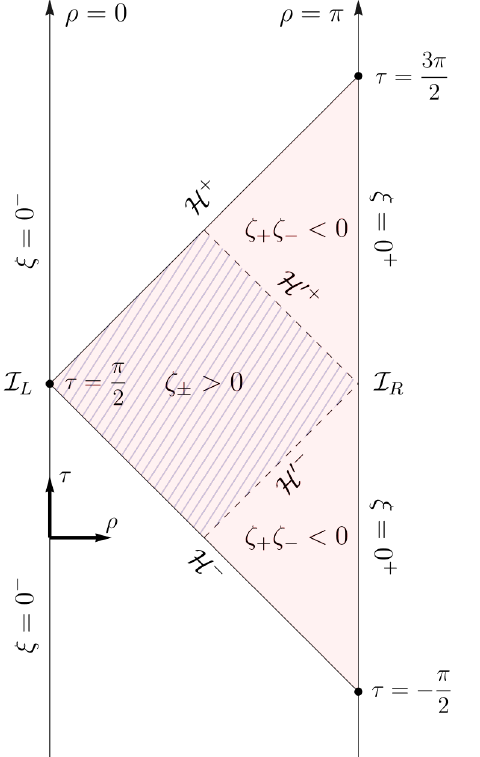
Figure 1 . Conformal diagram for the Poincaré patch of AdS 2 . The Cauchy horizons of the Poincaré patch are labelled H ± . After topological identification, the region ζ + ζ − < 0 presents CTCs, thus two new Cauchy horizons H 0± appear in the conformal diagram. In the compactified coordinates ( τ, ρ ) , the Poincaré patch is covered by ρ > | τ − π/ 2 | and ρ ∈ (0 , π )